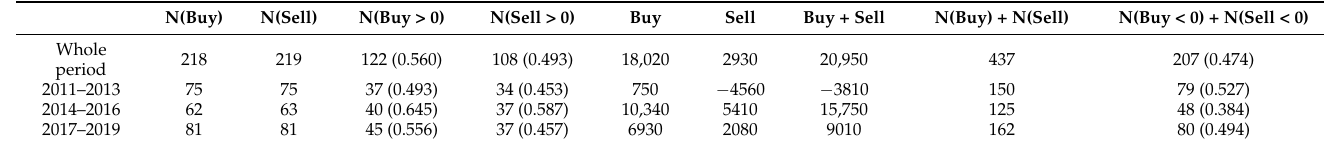
Table 5. The Performance of the MACD (4,22,3) Model with the Search for First Peak/Bottom-Point Strategy. N(Buy)